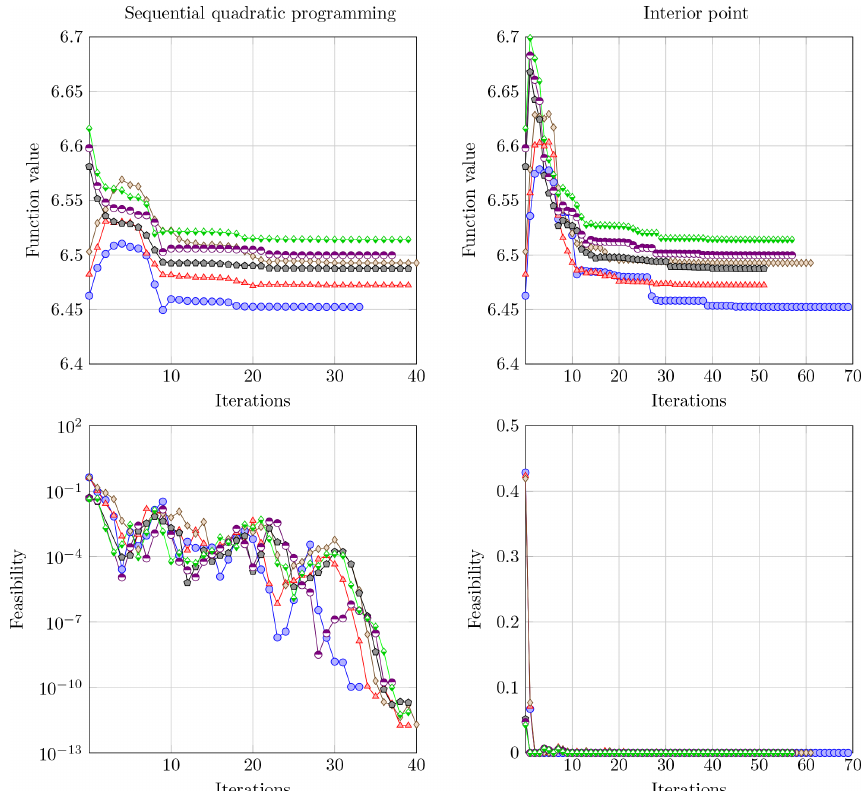
Figure 2. Function and feasibility (maximum constraint violation) values during the optimization procedure of all six subproblems (blue line with circles: jacket with three legs and three bays; red line with triangles: jacket with three legs and four bays; brown line with diamonds: jacket with three legs and five bays; black line with pentagons: jacket with four legs and three bays; violet line with half-filled circles: jacket with four legs and four bays; green line with half-filled diamonds: jacket with four legs and five bays). The starting point (iteration “0”) is the OC4 jacket with a varying number of legs and bays in all cases. One iteration involves 11 evaluations of the objective function and the nonlinear constraints. Table 2. Optimal solutions of design variables x ∗ obtained by the sequential quadratic programming method for fixed values of N L and N X